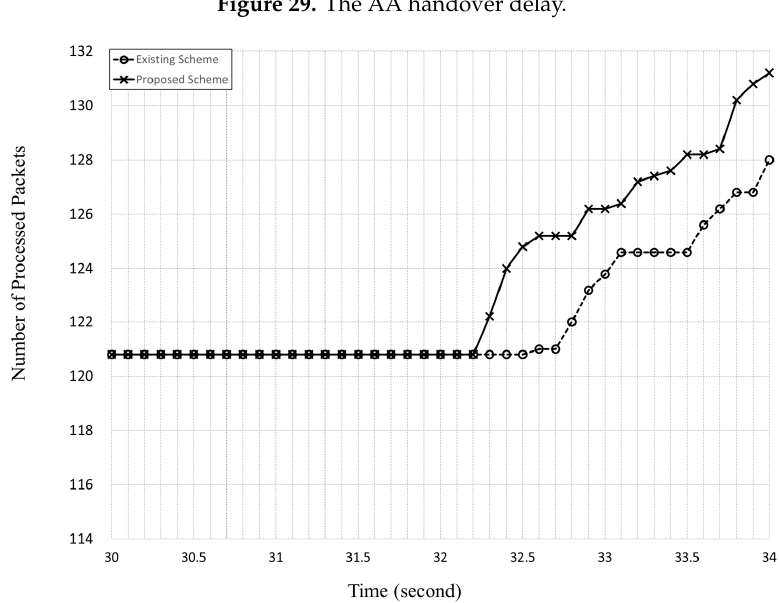
Figure 30. Analysis of packets processed during the AA handover.